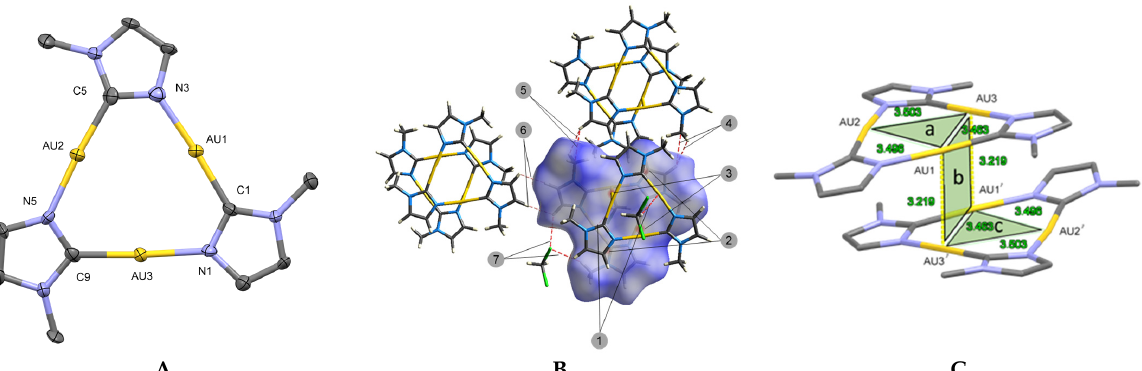
Figure 2. ( A ) A view of the molecular structure of the monomer of Au 3 (MeIm) 3 from solvatomorph β with displacement ellipsoids shown at 50% probability. Hydrogen atoms are omitted for clarity. (note that the monomer triangle molecules are identical in both polymorphs. See Figure S9). ( B ) Overview of the different non-covalent interactions around Au 3 (MeIm) 3 molecule within dimeric structure in solvatomorph β as determined by Hirshfeld surface analysis. (Note: Due to reasons of clarity not all symmetry equivalent interactions are depicted in the figure). ( C ) Dimer-of-trimer formation found in solvatomorph β . Solvent molecules are omitted for clarity. Selected bond lengths (Å): Au1···Au2, 3.4961(9) Å; Au2···Au3, 3.5032(8) Å; Au3···Au1, 3.4636(7) Å; Selected angles (Å) C-Au1-N, 175.8(4)°; C-Au2-N, 173.5(4)°; C-Au3-N, 175.3(1)°.